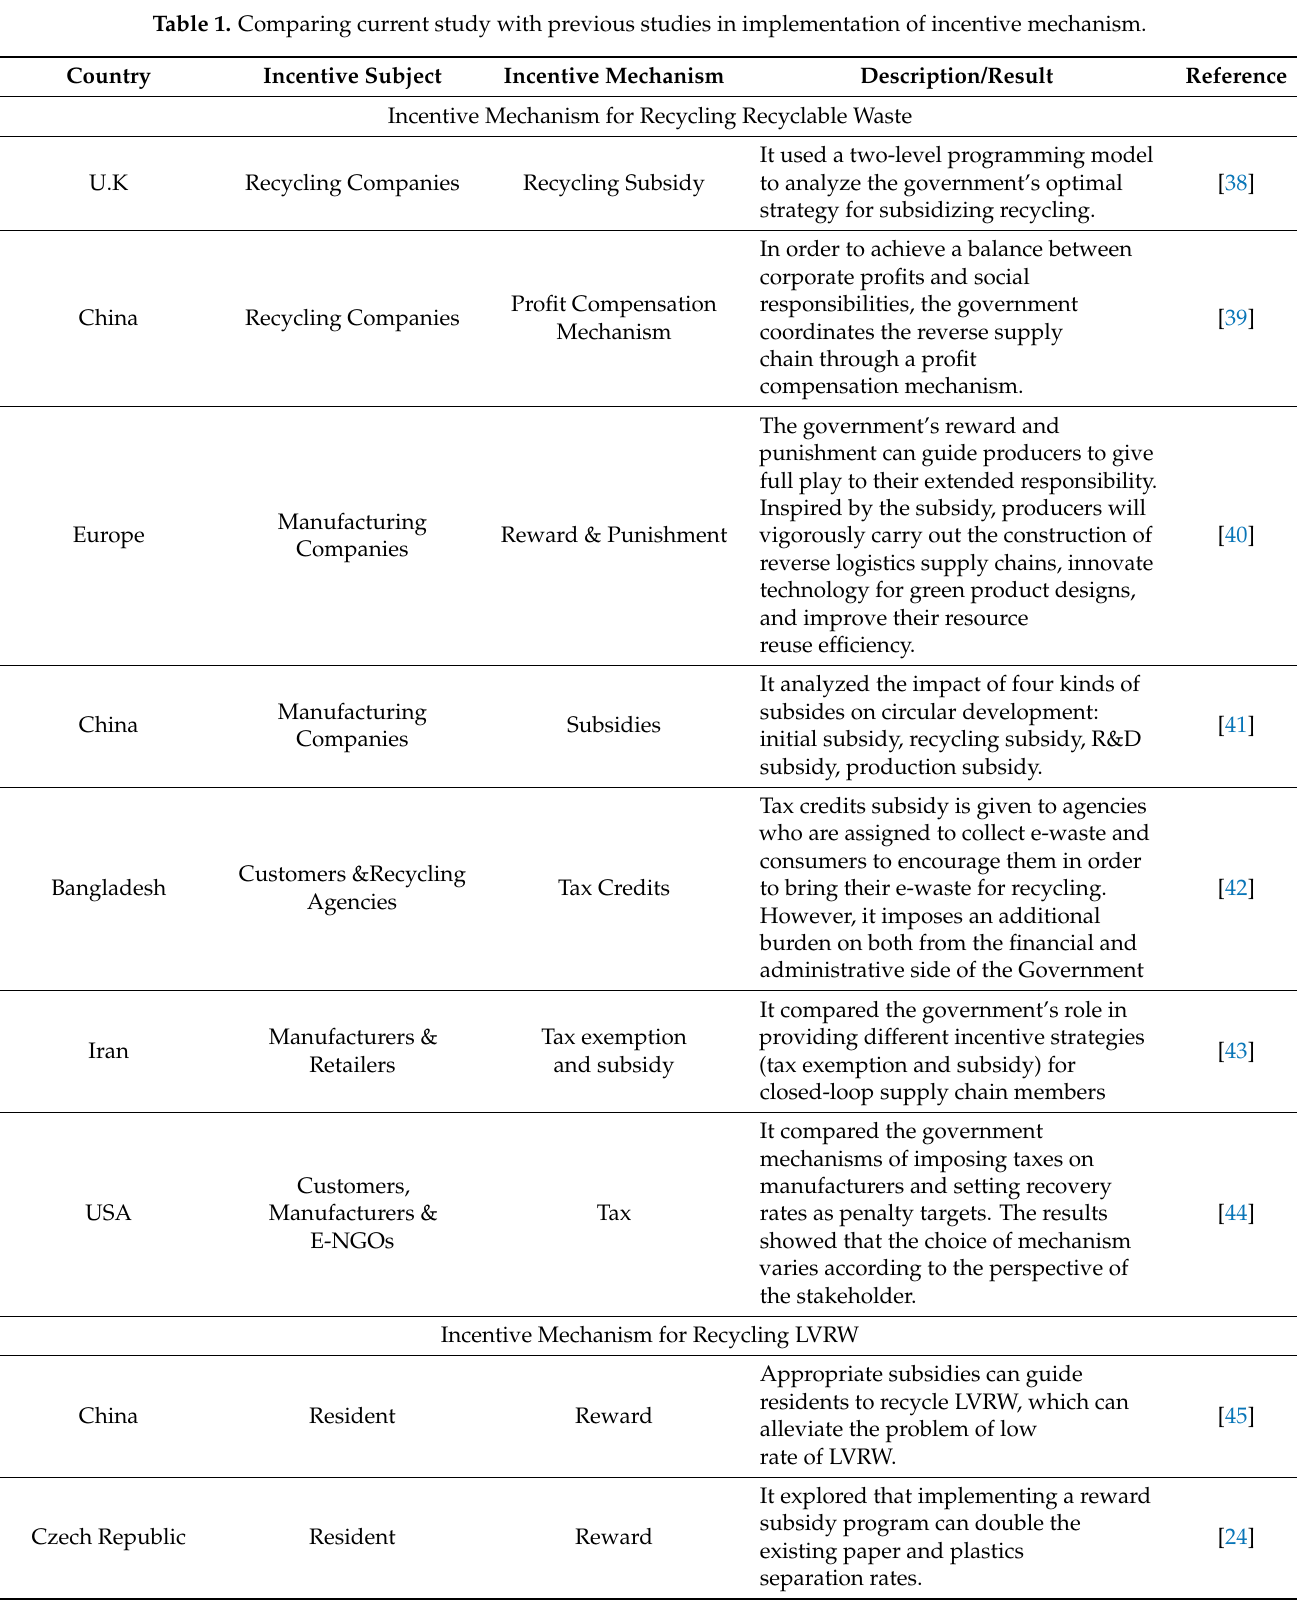
Table 1. Comparing current study with previous studies in implementation of incentive mechanism.